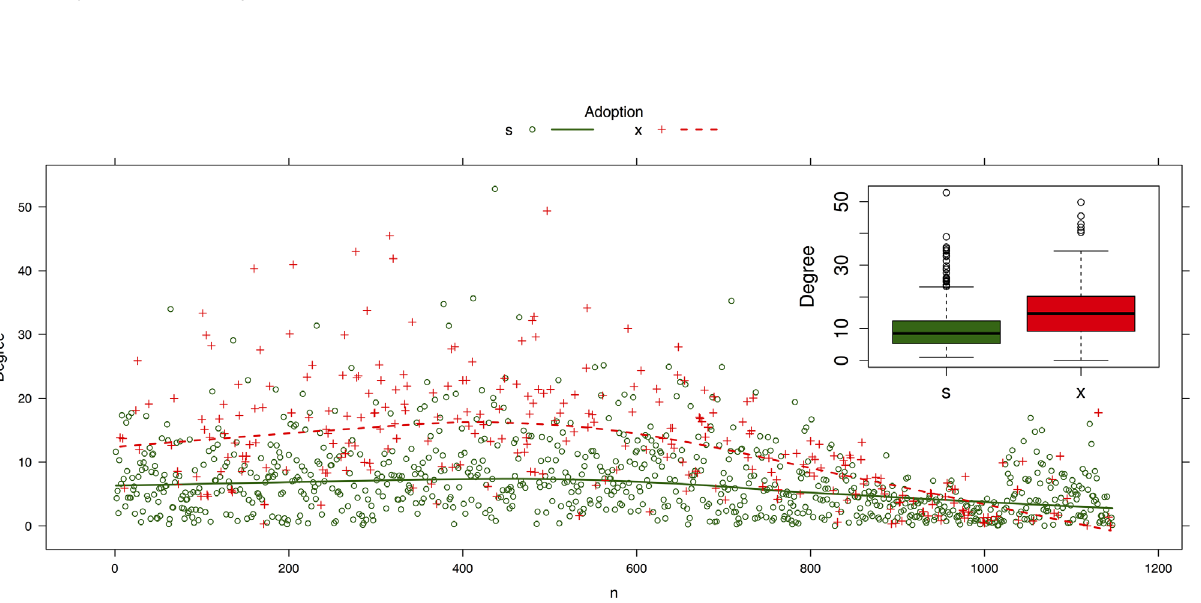
PLOS ONE | DOI:10.1371/journal.pone.0140891 October 27,